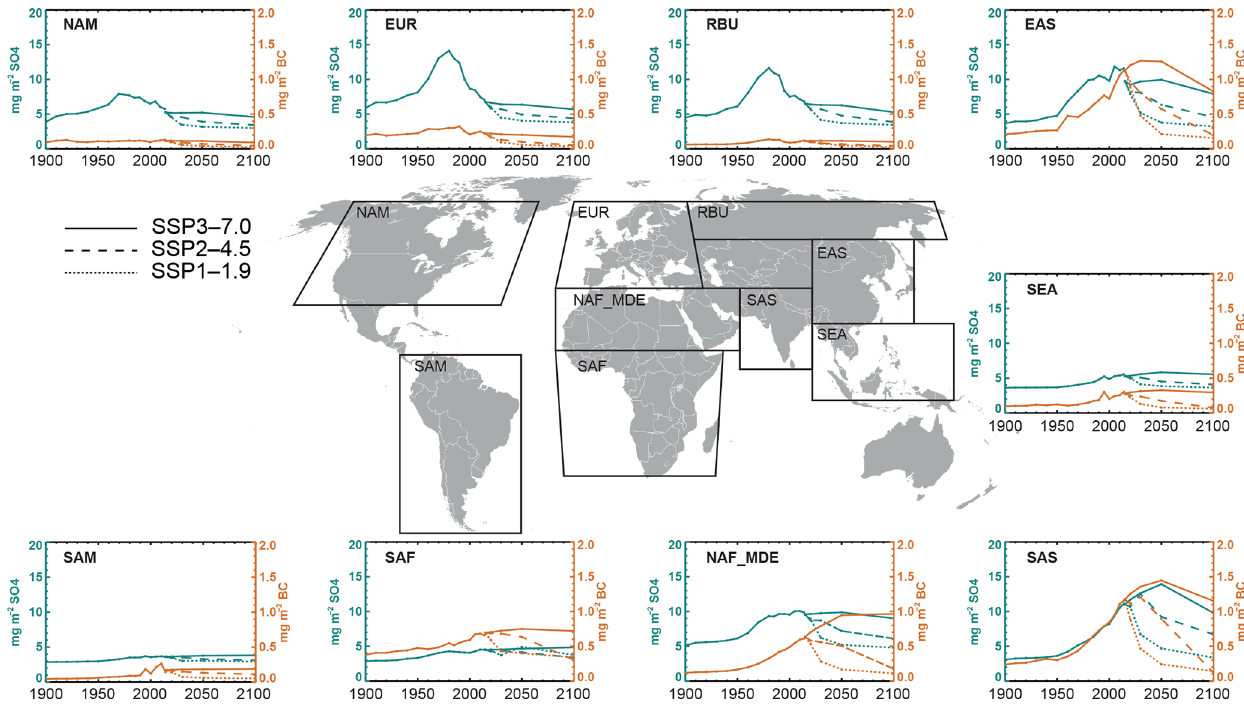
Figure 2. Regionally averaged burdens of BC and sulfate aerosols from 1900 to 2100 using CEDS historical emissions and SSP1-1.9, SSP2-4.5 and